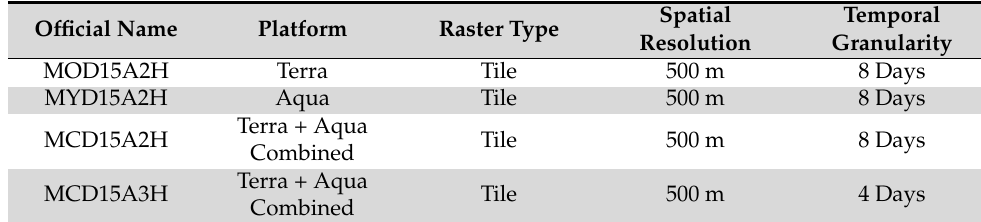
Table 1. Description of the standard MODIS LAI/FPAR